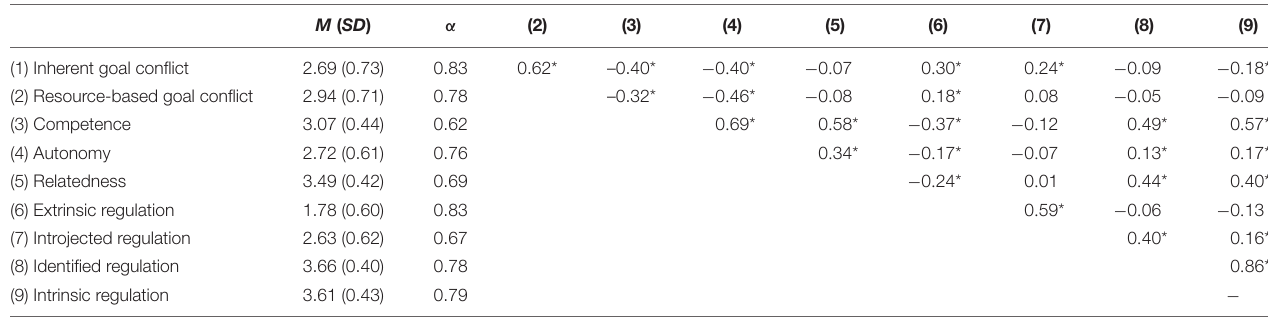
TABLE 1 | Descriptive statistics, internal consistency, and bivariate correlations based on latent scale